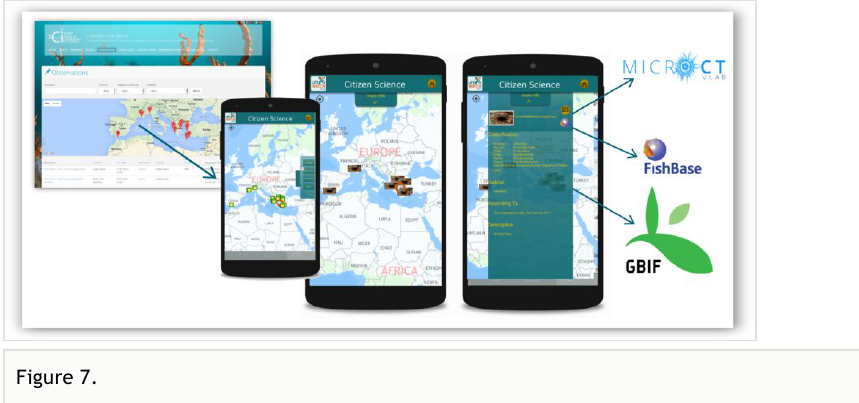
Interface of the smartphone application displaying the exchange of information between di ff erent applications of LifeWatchGreece infrastructure and global biodiversity